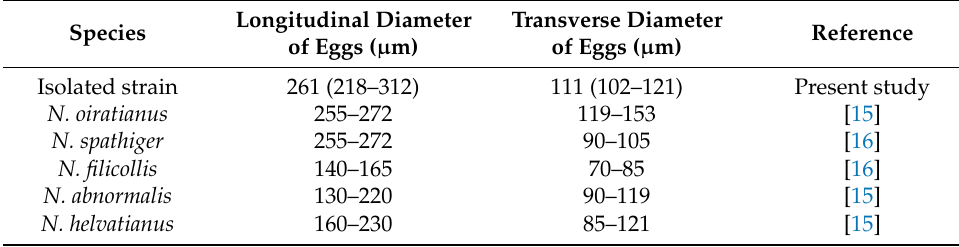
Table 1. Statistics on egg size of Nematodirus